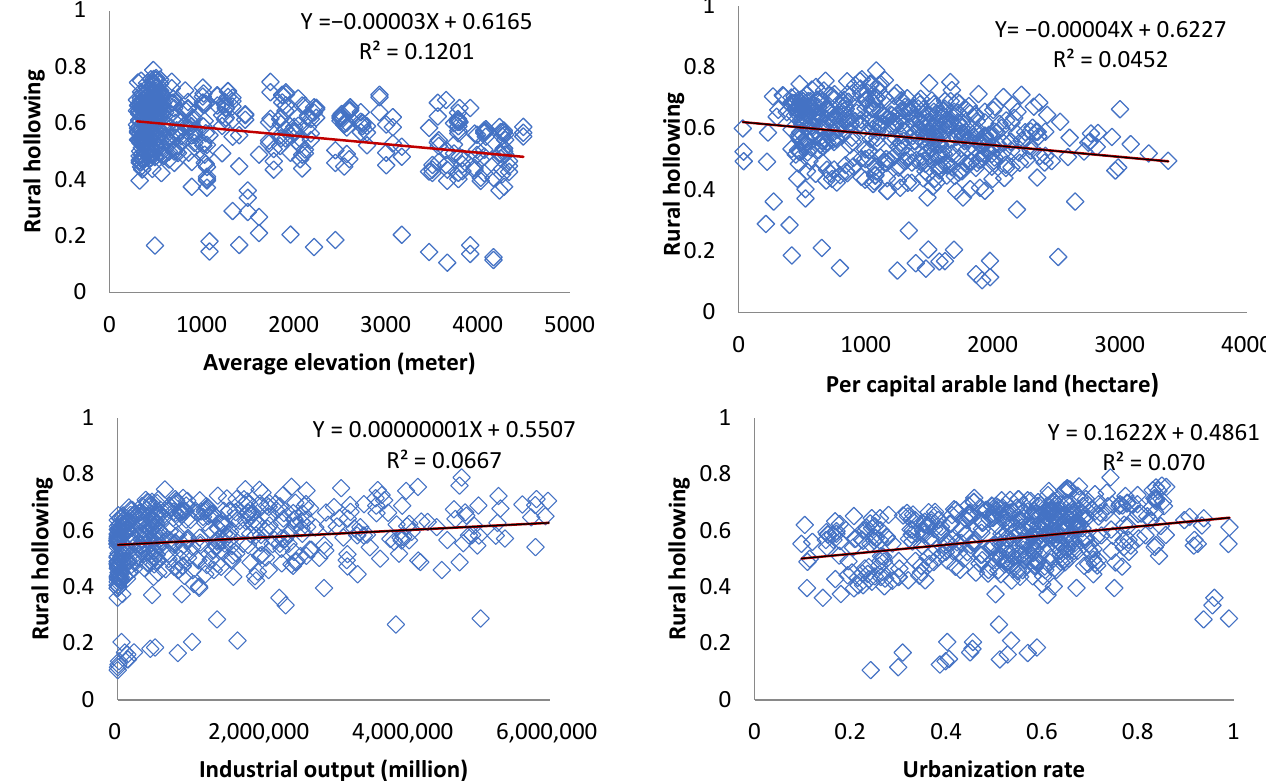
Figure 9. Scatter plot of influencing factors of rural hollowing. Table 7. Correlation of influencing factors of rural hollowing in Sichuan Province. Rural Hollowing Degree